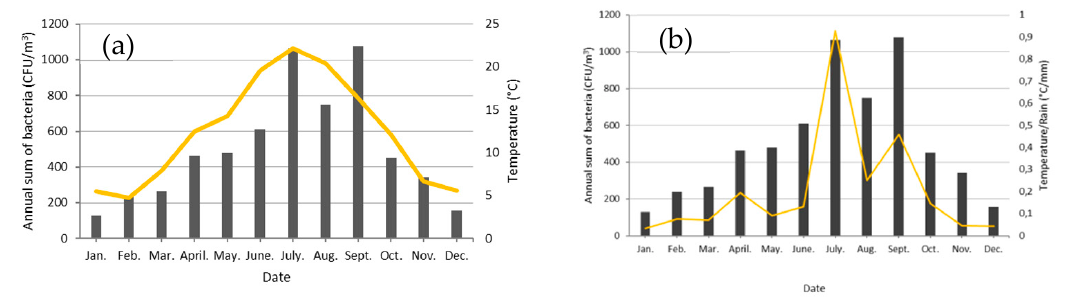
Figure 11. ( a ) Monthly Sum of Bacterial Concentrations (Bars in CFU/m 3 ) and Temperature (yellow curve in °C) and ( b ) Monthly Sum of Bacterial Concentrations (Bars in CFU/m 3 ) and Temperature/Rain (yellow curve in °C/mm) from 10 January 2018 to 31 March 2020.